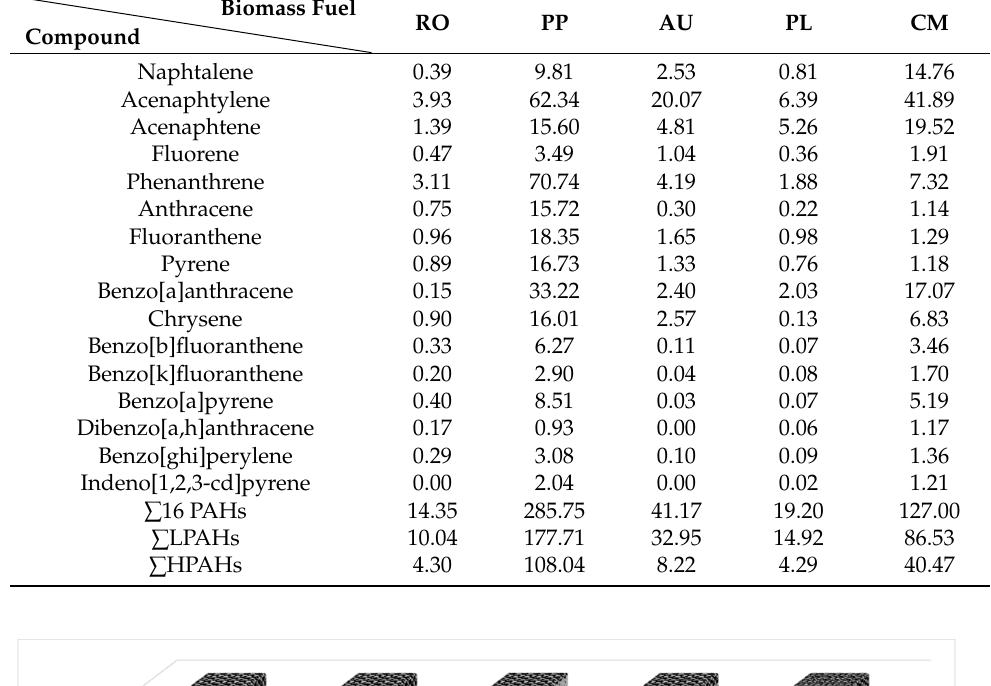
Table 4. Concentration of PAHs in biomass soot (ng/mg of soot).